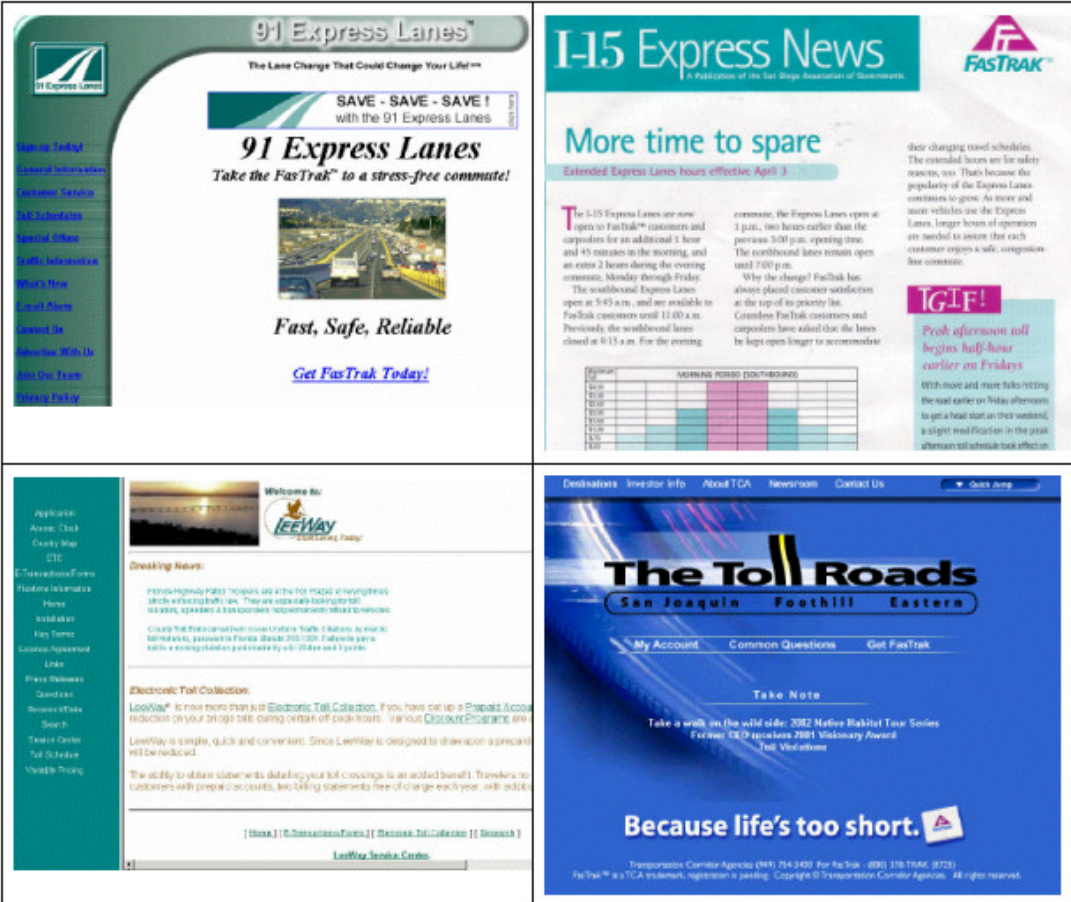
Figure 1. Marketing Images for Selected U.S. Value Pricing